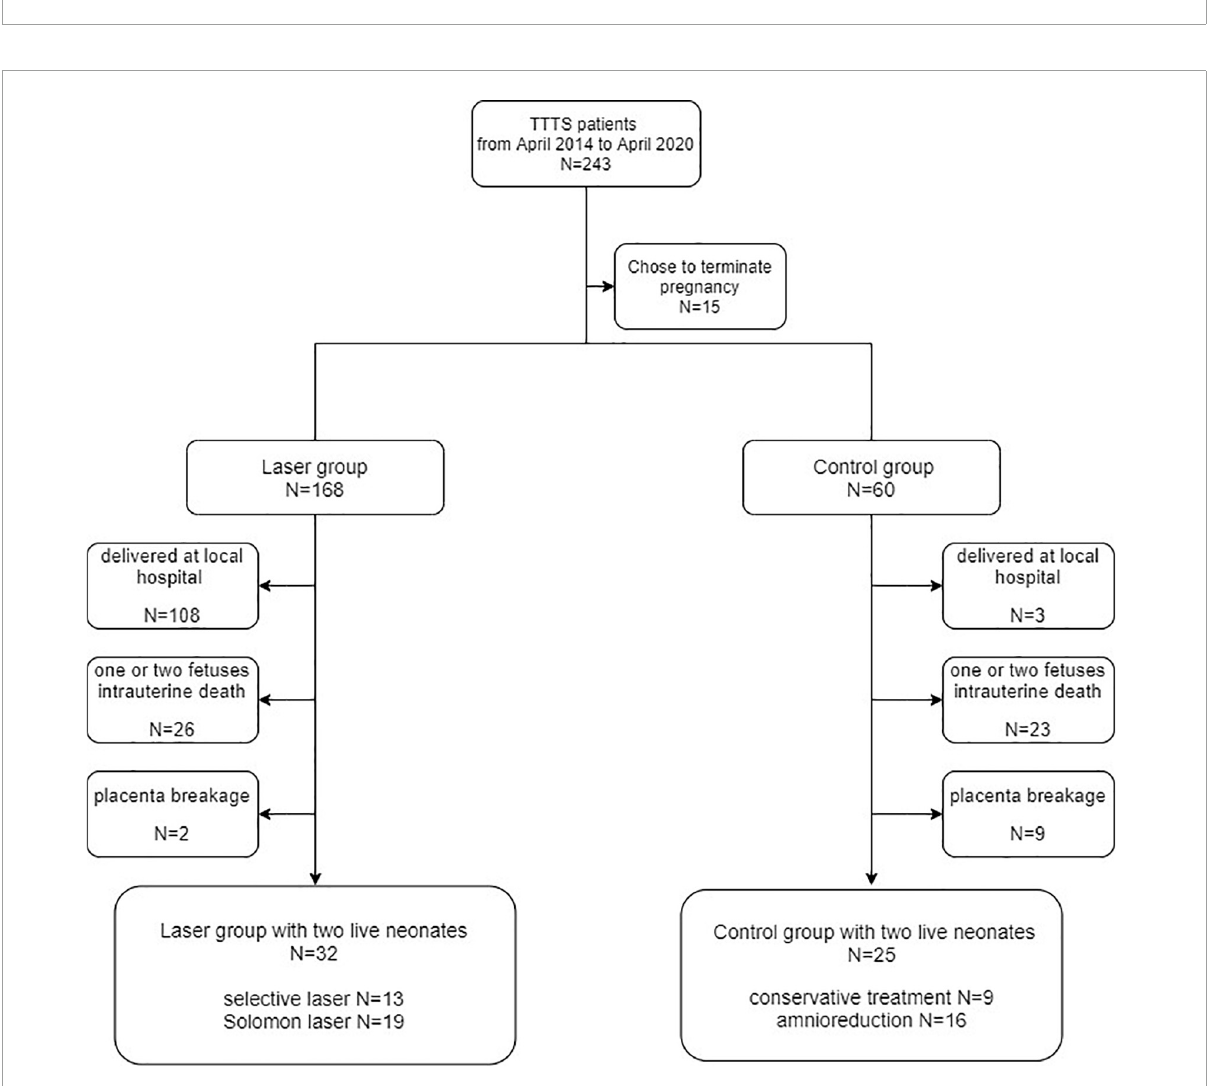
FIGURE2 Flowcharts depicting the patient inclusion